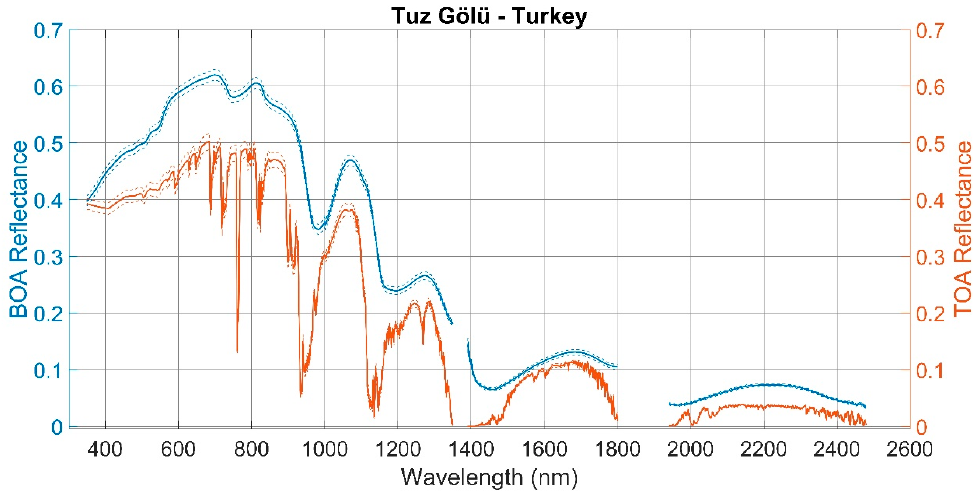
Figure 1. In the y -axis left and right side of the graph is presented, respectively, the Bottom-of-Atmosphere (BOA) and Top-of-Atmosphere (TOA) reflectance of Tuz Gölü measured in situ in August